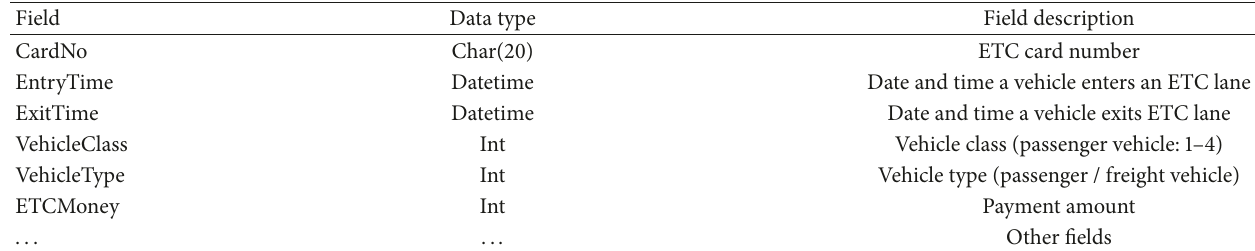
Table 1: ETC data